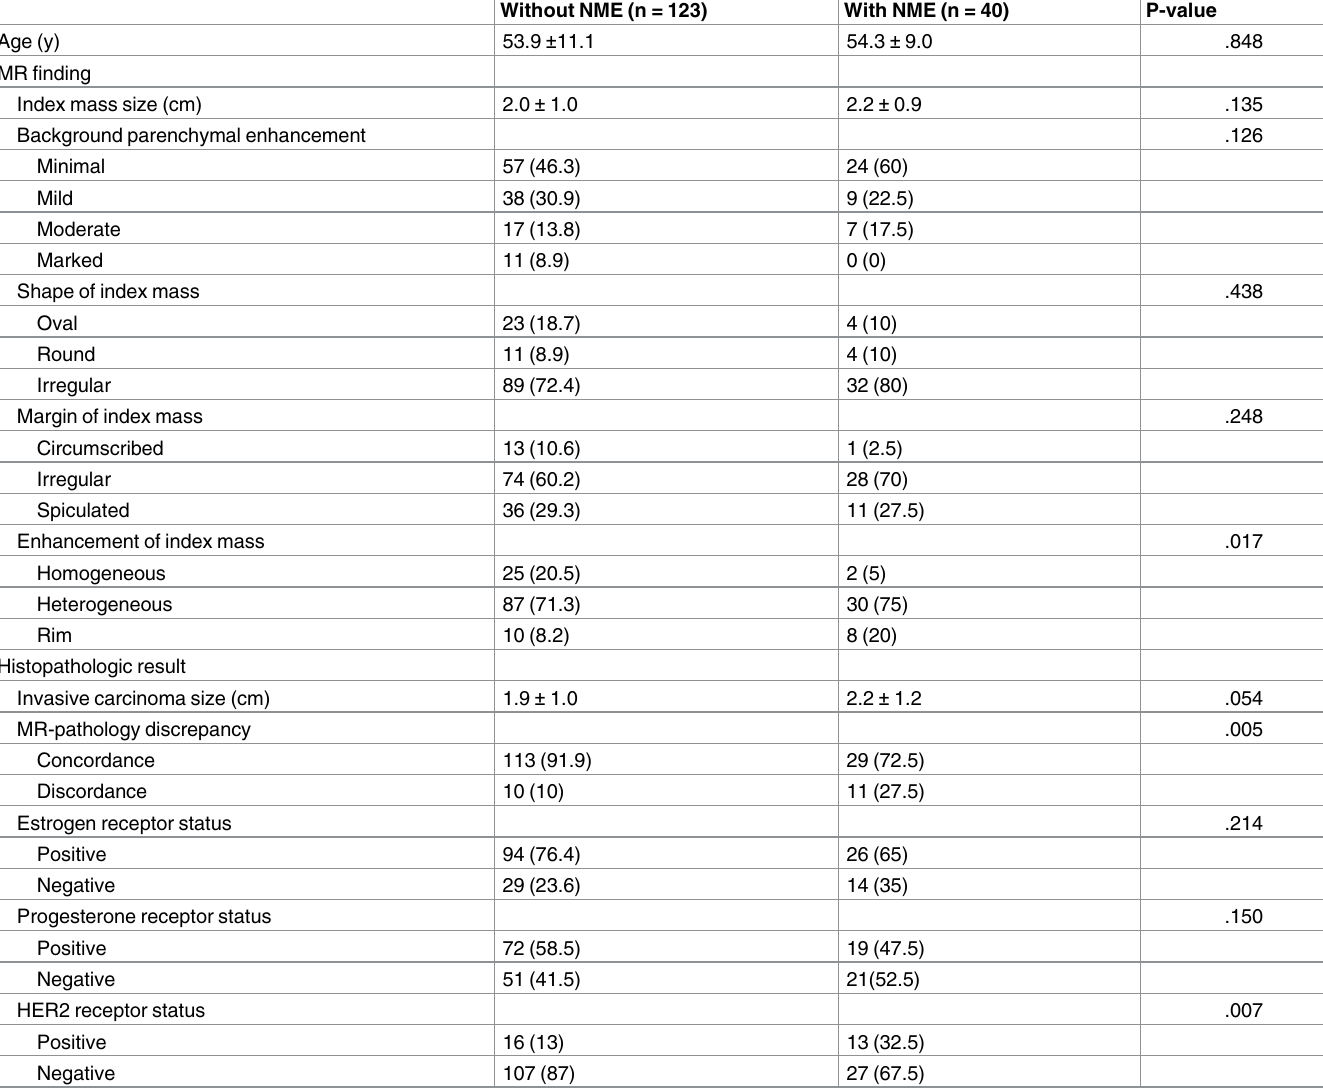
Table 1. Characteristics of patients without NME and with accompanying NME in MR